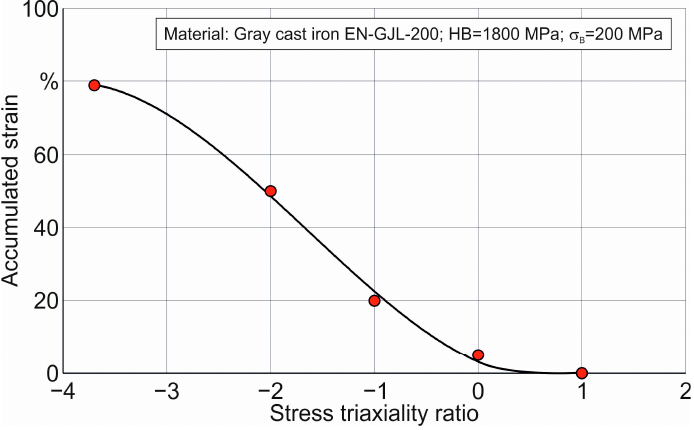
Figure 1. Plasticity diagram of cast iron EN-GJL-200.